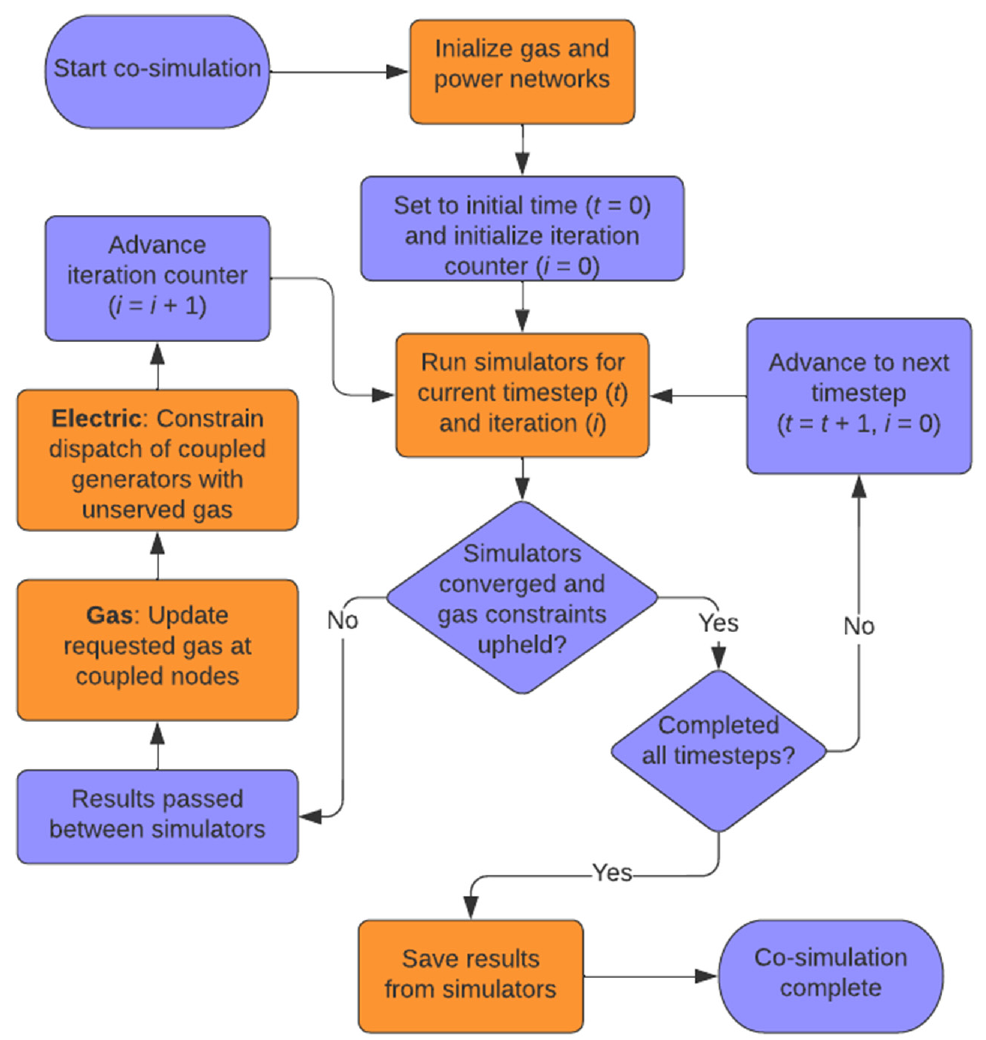
Figure 2. Analytical structure of the co-simulation framework, where t represents a timestep and i represents an iteration. Objects in purple indicate stages coordinated by the HELICS co-simulation framework, and objects in orange indicate stages run by the gas and electric federates. The electric and gas federates iterate on each timestep until convergence and then move to the subsequent timestep.